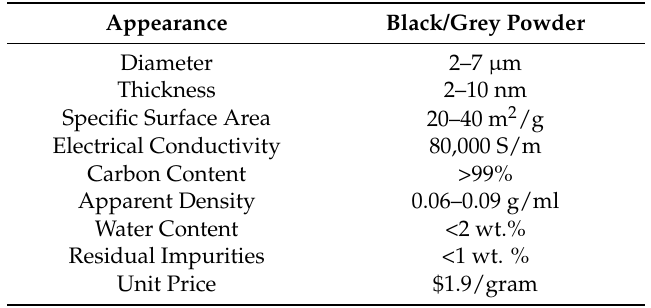
Table 1. The properties of Graphene Nano-Platelets (GNPs).